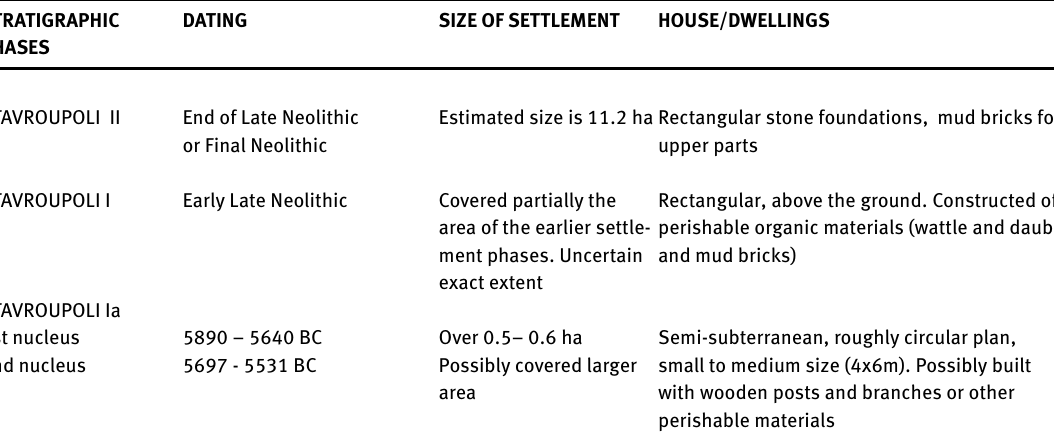
Table 1. General information about Stavroupoli’s stratigraphy and